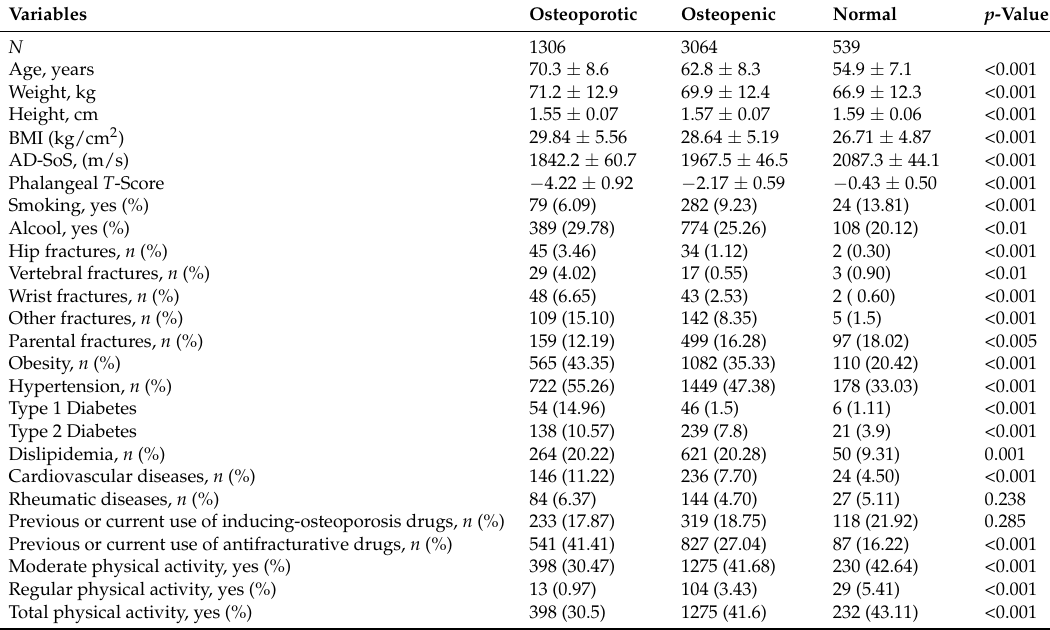
Table 1. Baseline characteristics of postmenopausal women stratified by bone mineralization status. Variables Osteoporotic Osteopenic